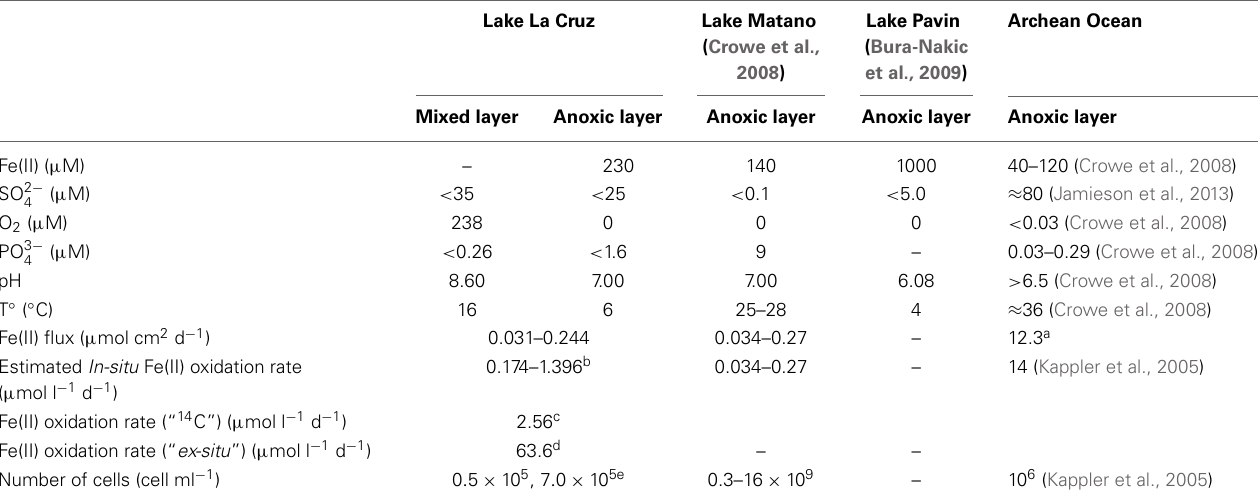
Table 2 | Comparison of water chemistry, iron fluxes toward the oxic/anoxic interface, and Fe(II)-oxidation rates of different potential modern Archean Ocean